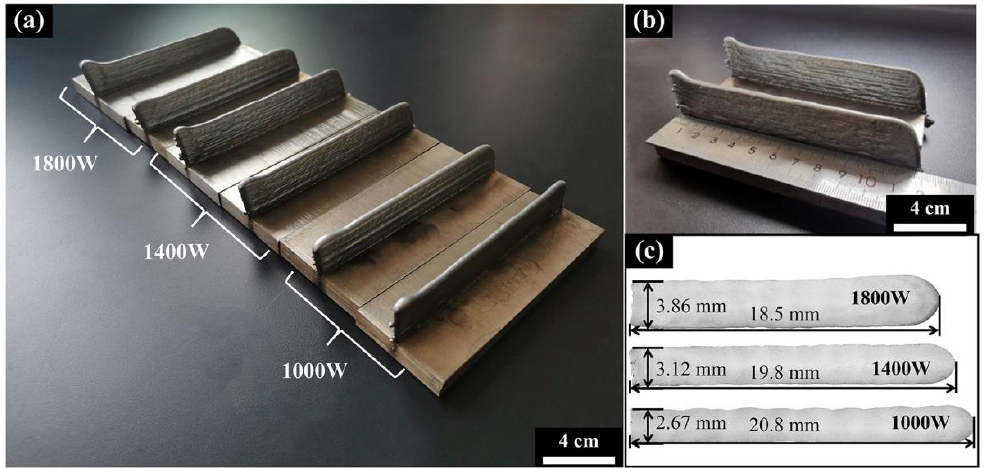
Figure 4. The Al 0.5 FeCoCrNi wall manufactured by LMD: ( a ) macrostructure; ( b , c ) specimen di- mensions.